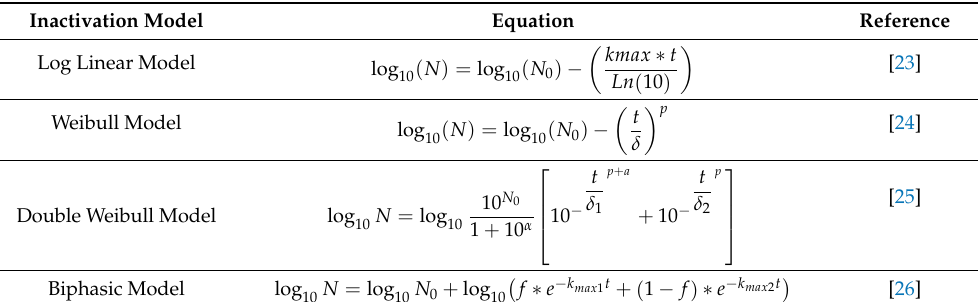
Table 2. Microbial inactivation models.